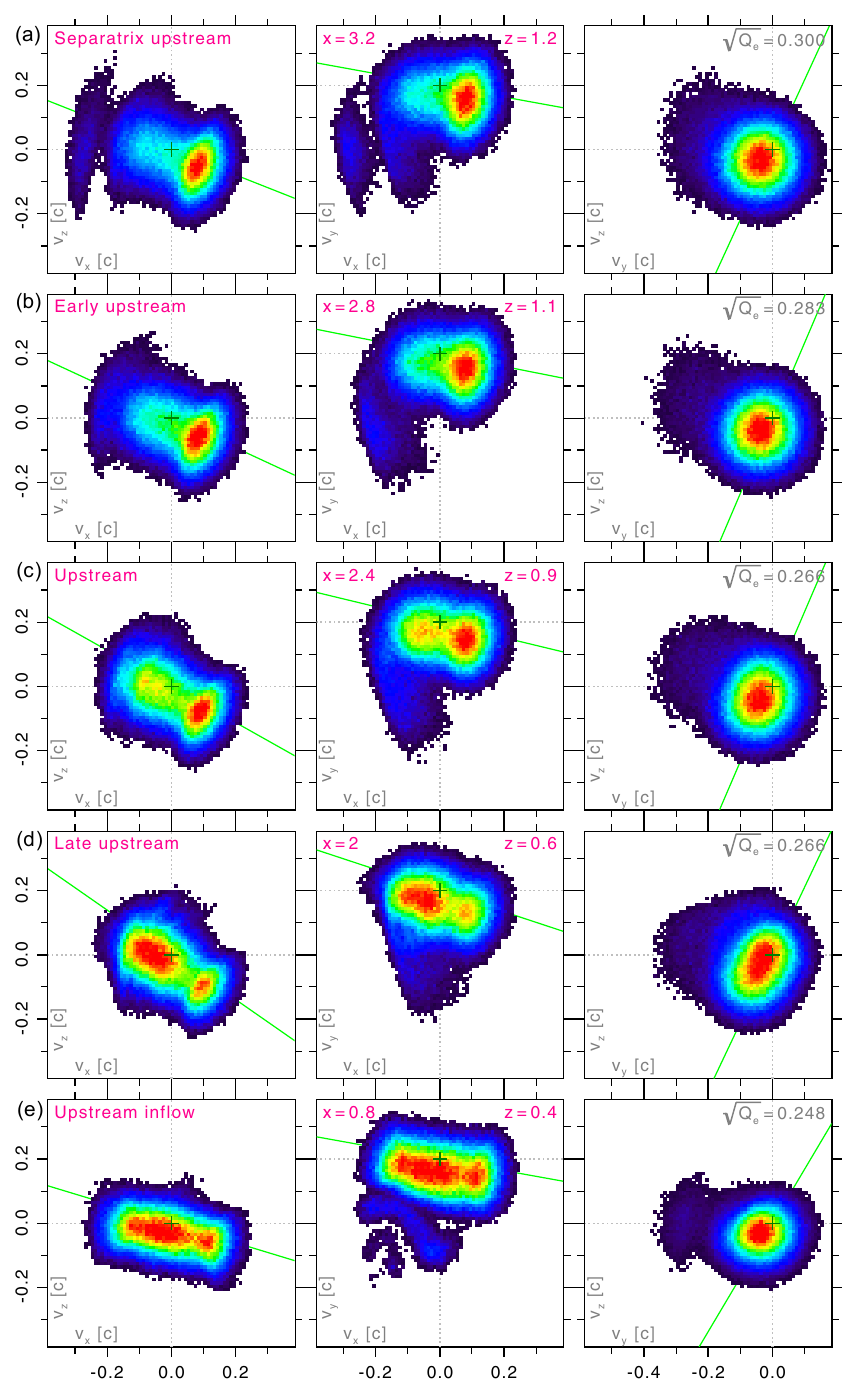
Figure 11. Same as Fig. 5 but following the separatrix layer in the upstream direction towards the